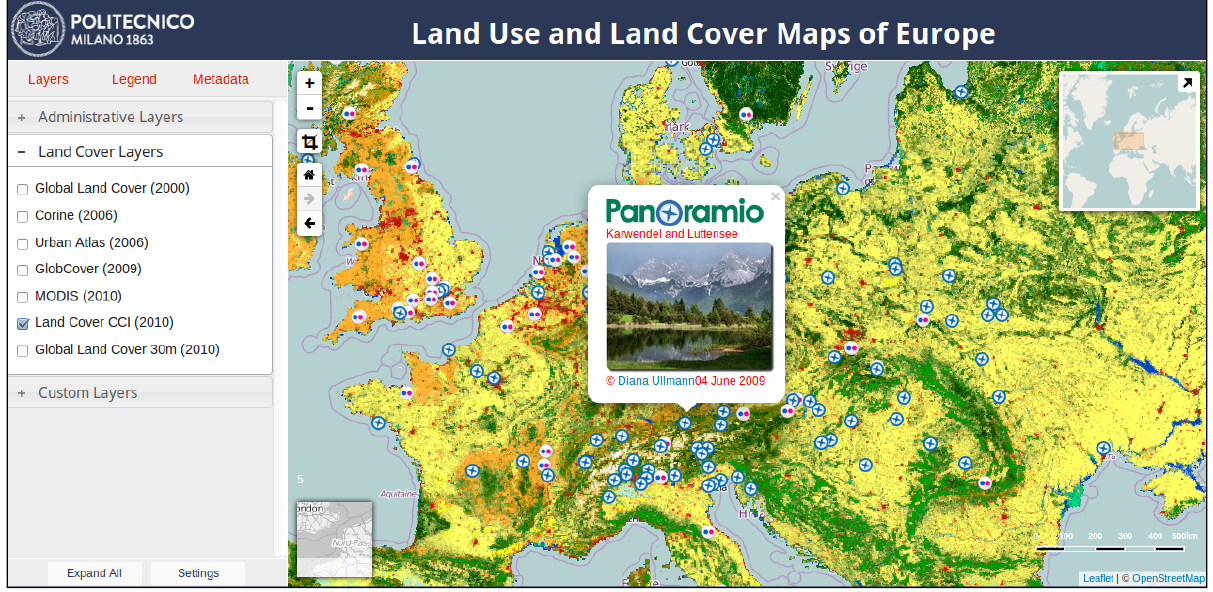
Figure 2. Screenshot of the EU-LULC WebGIS